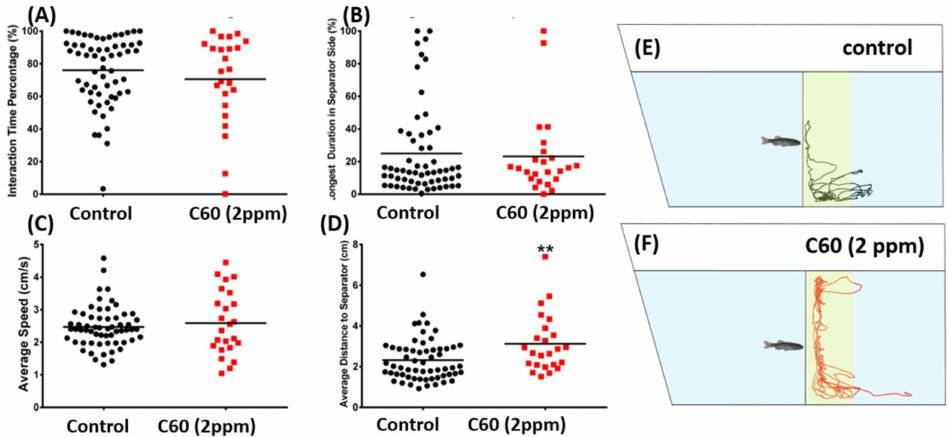
Figure 7. Comparison of conspecific behavior endpoints between wild-type and C 60 NPs-exposed zebrafish after nine-day exposure. ( A ) Interaction time percentage, ( B ) longest duration in separator side, ( C ) average speed, and ( D ) average distance to separator were analyzed. The swimming trajectories of control (black color in ( E )) and C 60 NPs-exposed fish (red color in ( F )) for social interaction test were recorded and compared. The data are expressed as the means and were analyzed by